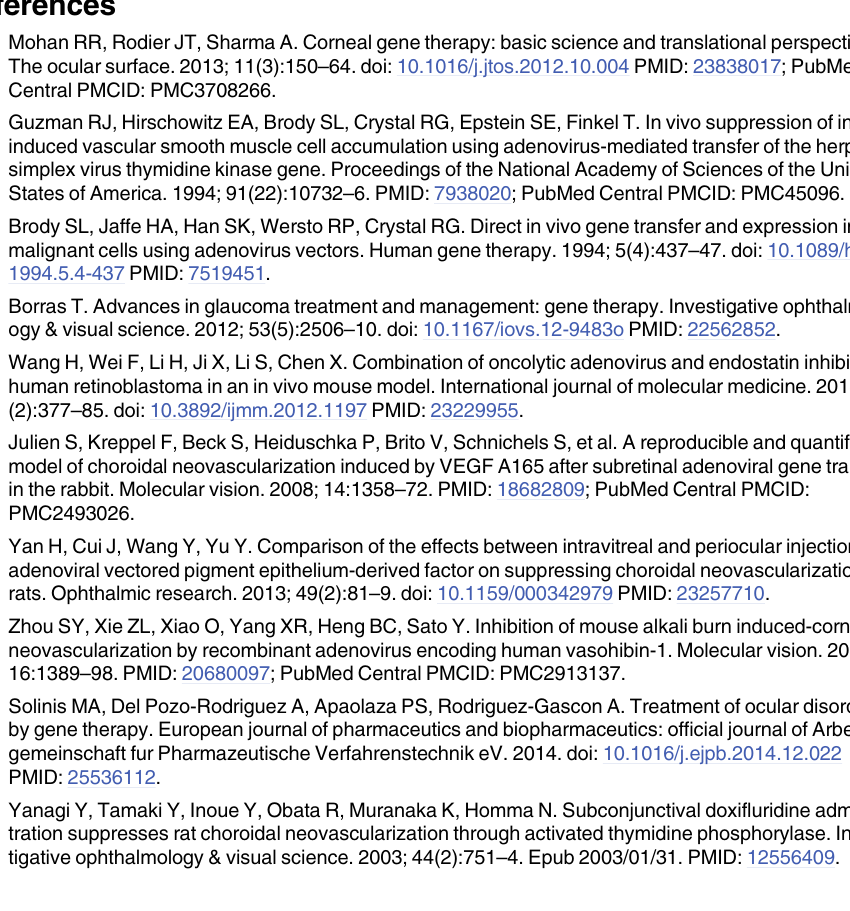
S1 Fig. Timeline of the study to characterize the adenovirus-mediated gene delivery via sub- conjunctival administration. (TIF) S2 Fig. Standard curves of adenoviral genome copies for quantitative PCR standards.